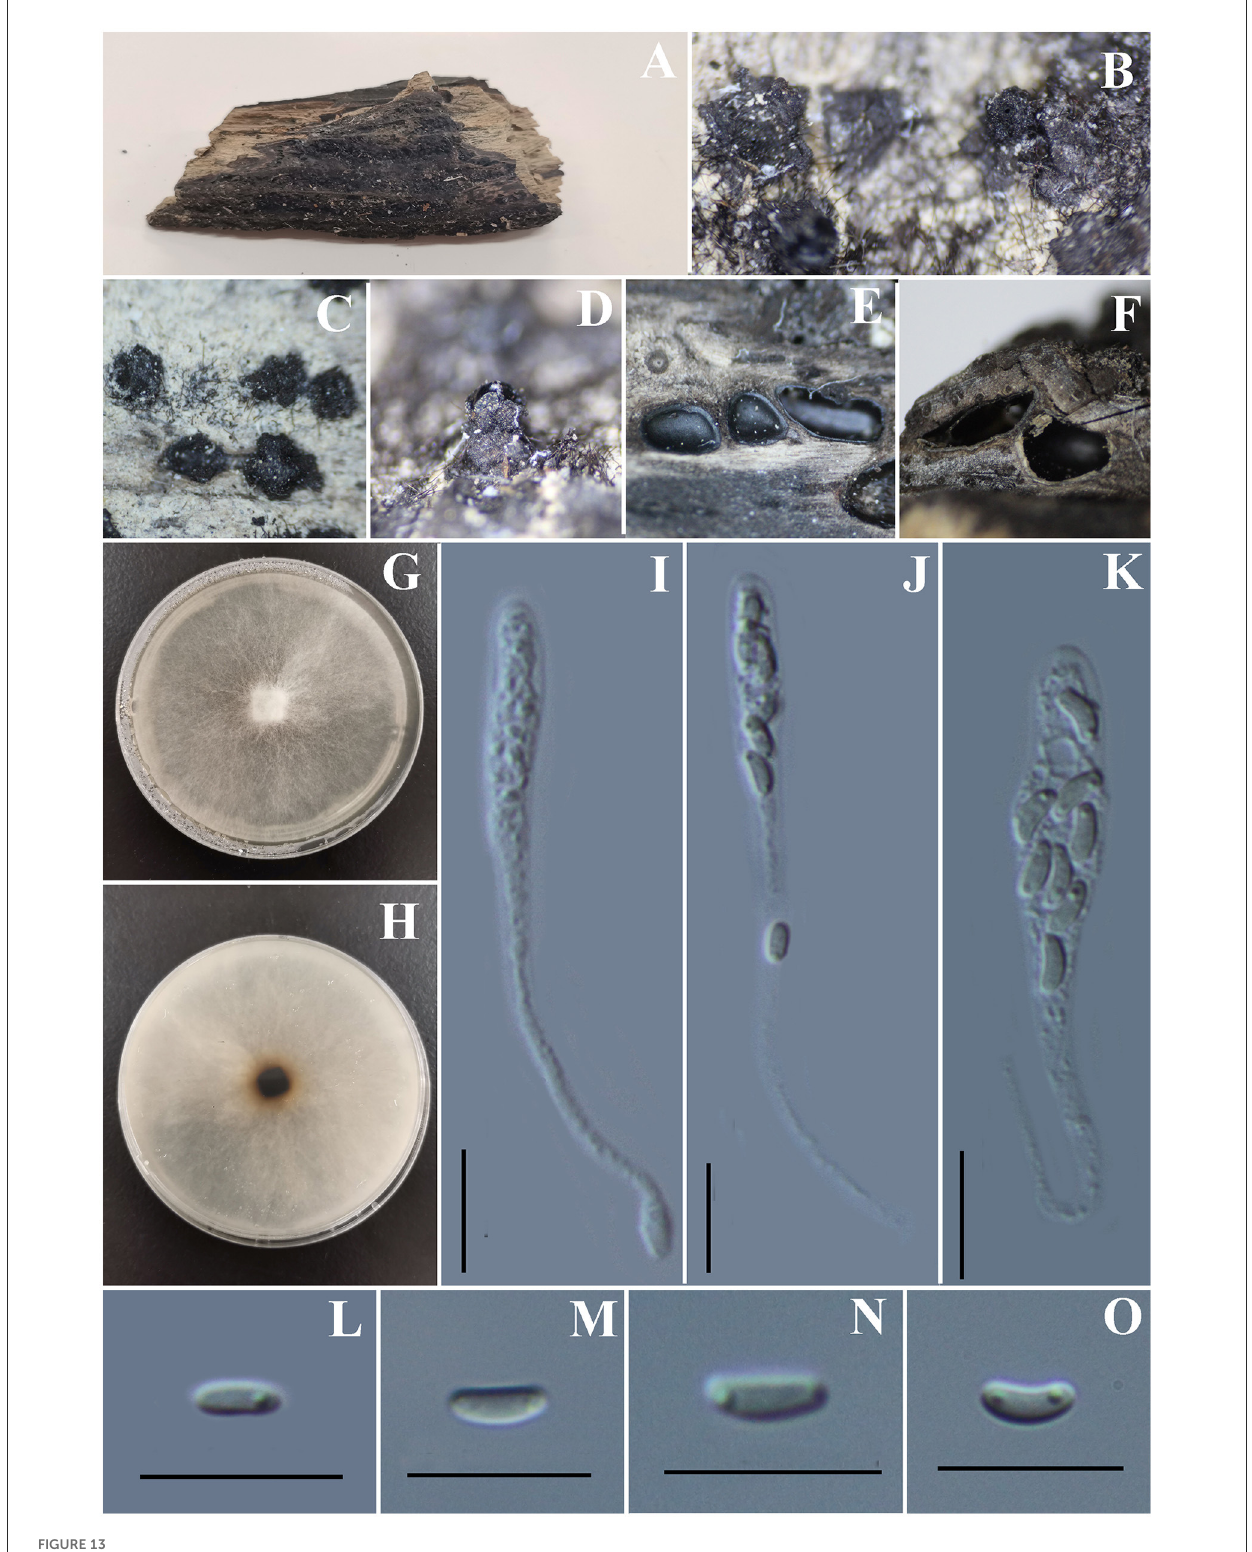
FIGURE13 Vasilyeva cinnamomi (GMB0418, holotype). (A) Type material. (B–D) Close-up of stromata. (E) Transverse section through stromata. (F) Vertical section through stromata. (G, H) Culture on PDA. (I–K) Asci. (L–O) Ascospores. Scale bars: (C–F) = 1mm; (I–O) = 10 µ